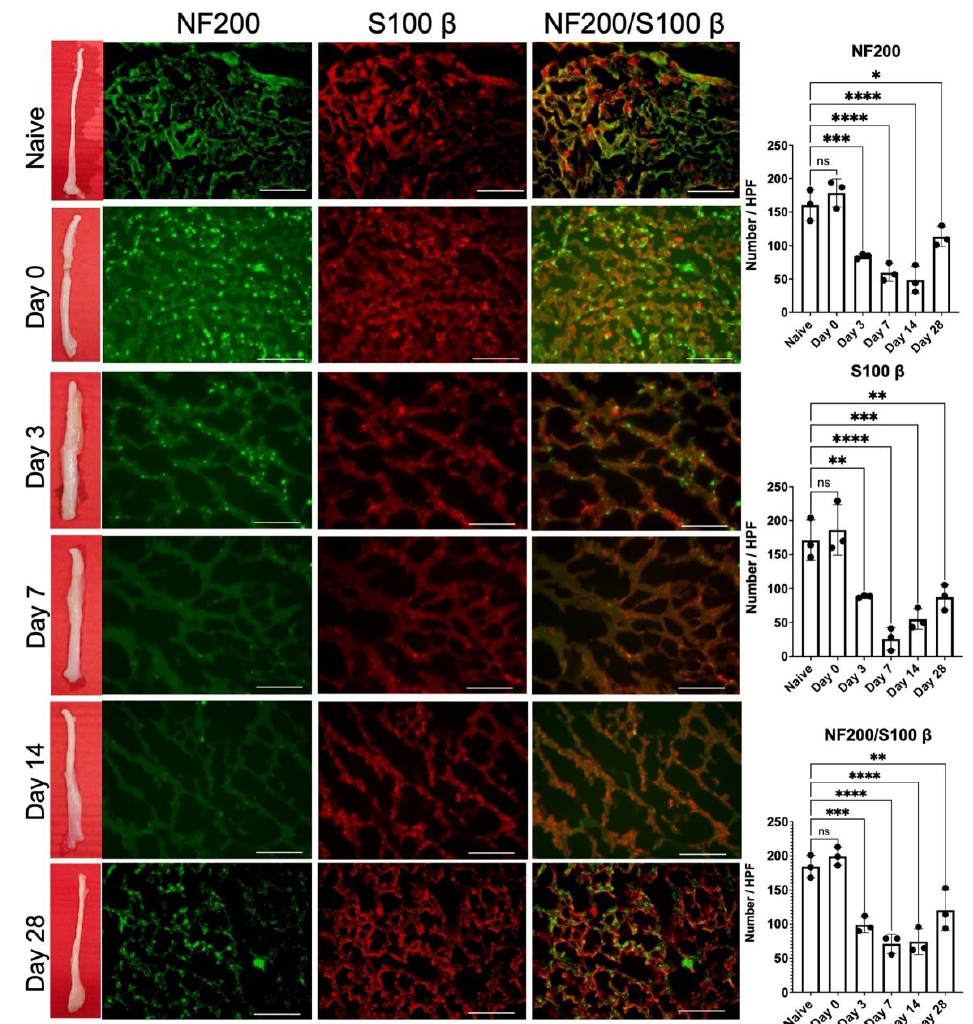
Figure 3. Immunohistochemical staining of injured sciatic nerve for axon myelination. Gross nerve image demonstrated apparent nerve constriction at nerve release day 0, followed by nerve swelling till day 14. No apparent nerve damage was observed at day 28. Mature axon staining with NF200 revealed significant decrease of signal intensity from day 0 to day 14, with partial increase at day 28. Similar pattern was also observed in Schwann cell staining with S100 β along and double staining image. Double staining of NF200/S100 β revealed degree of myelinated axon after nerve release. (n = 3 per timepoint; Naïve nerve: contralateral uninjured nerve; Scale bar: 50 µ m; * indicated p < 0.05, ** indicated p < 0.01, *** indicated p < 0.001, **** indicated p < 0.0001, ns indicated no significant difference).